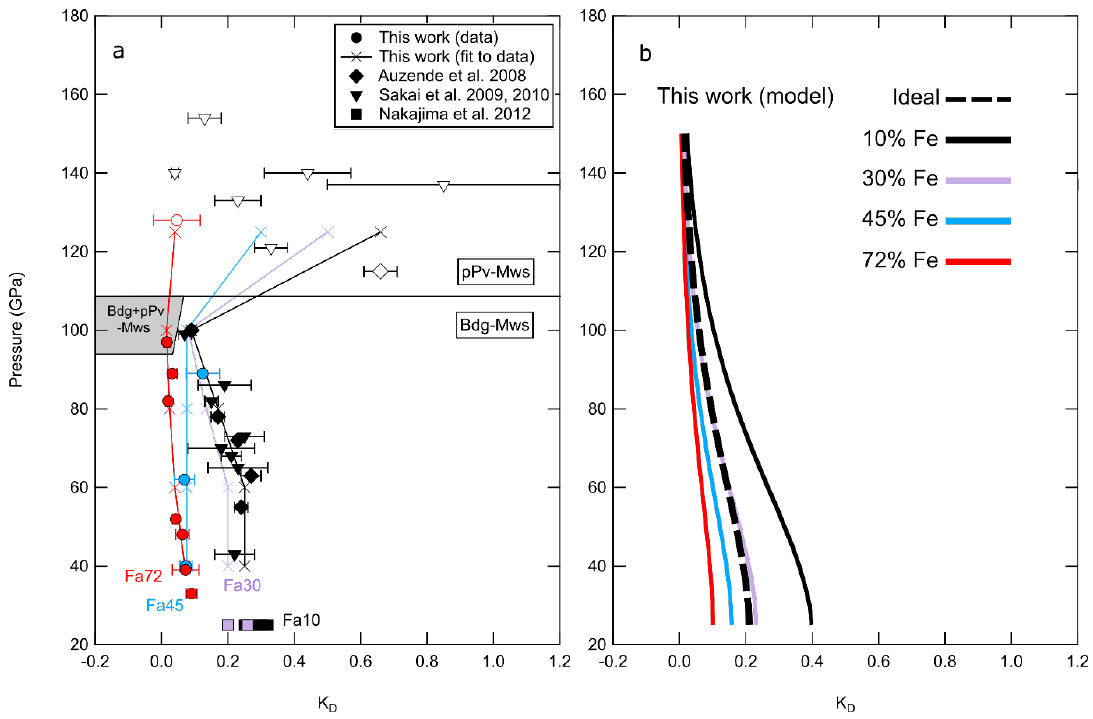
Figure 4. ( a ) Exchange coefficient between silicate and oxide phases at lower mantle conditions from experiments in this and previous studies [8,10–12] compared to thermodynamic models. Filled/open symbols indicate a bridgmanite/post- perovskite silicate phase. For most data, temperatures were in the range 1850–2200 K (temperatures for all data in this study listed in Table 1). Light gray region indicates composition/pressure space with coexisting bridgmanite and post-perovskite. Values chosen for fit to compositions Fa10, Fa30, Fa45, and Fa72 at selected pressures 40, 60, 80, 100, and 125 GPa are shown in ‘x’ symbols and lines. ( b ) Modeled pressure- and composition-dependence of partitioning behavior between bridgmanite and ferropericlase in olivine bulk compositions assuming ideal mixing (black dashed curve) and nonideal mixing (solid curves) using updated thermodynamic parameters based on thermal equation of state of FeO by [42] and inversion of experimental partitioning data in this study.